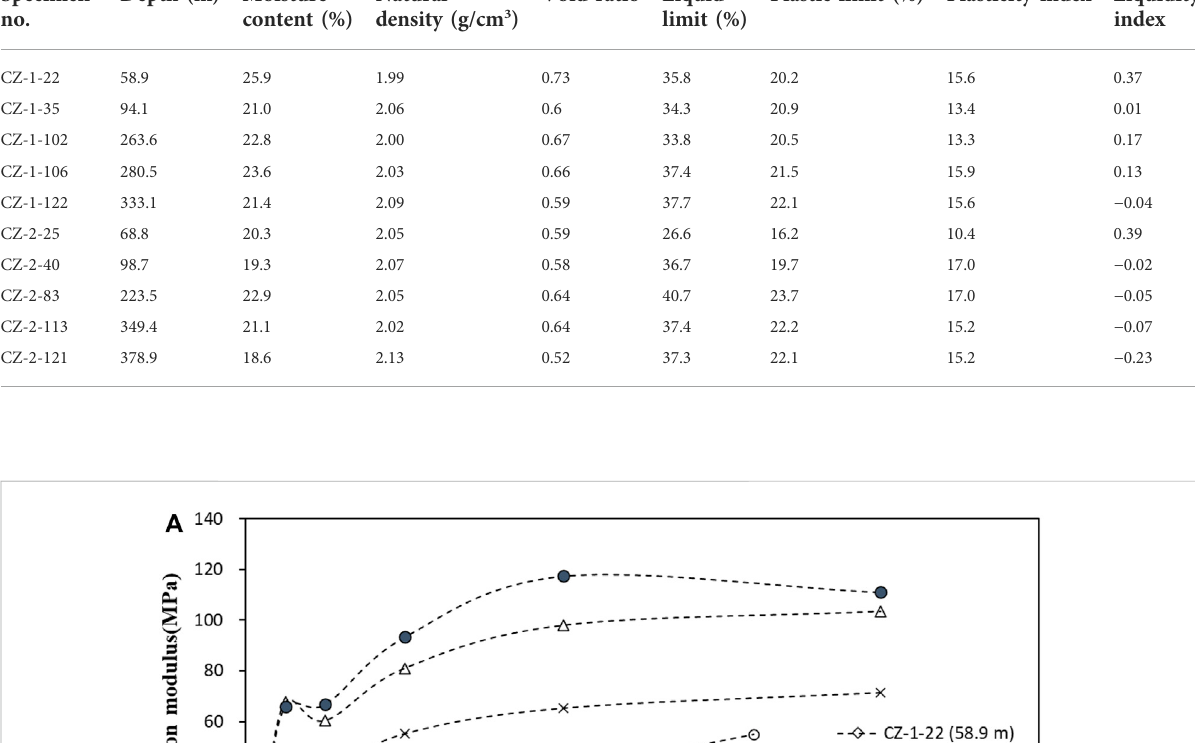
TABLE 2 Physico-mechanical properties of ten soil specimens taken from borehole CZ-1 and CZ-2. Specimen no.